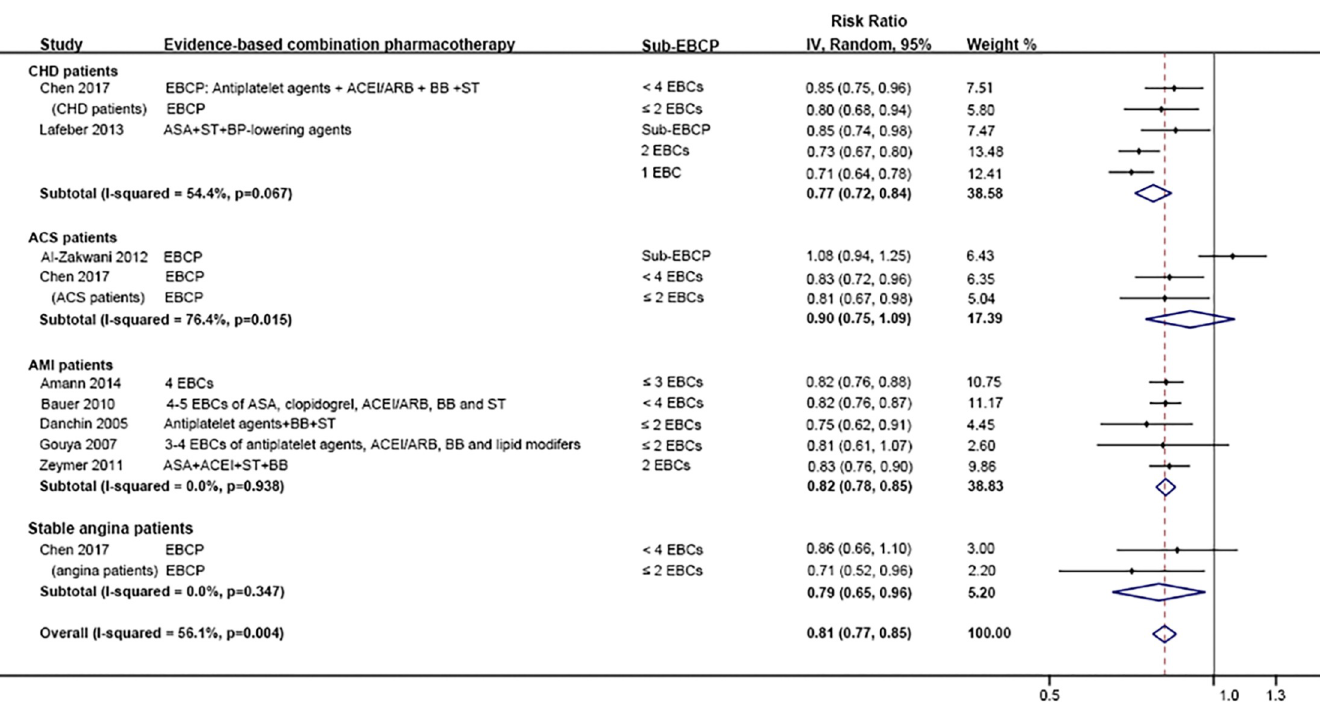
Fig 4. Comparison: EBCP versus sub-EBCP ( < 4 components), Outcome: All-cause mortality.